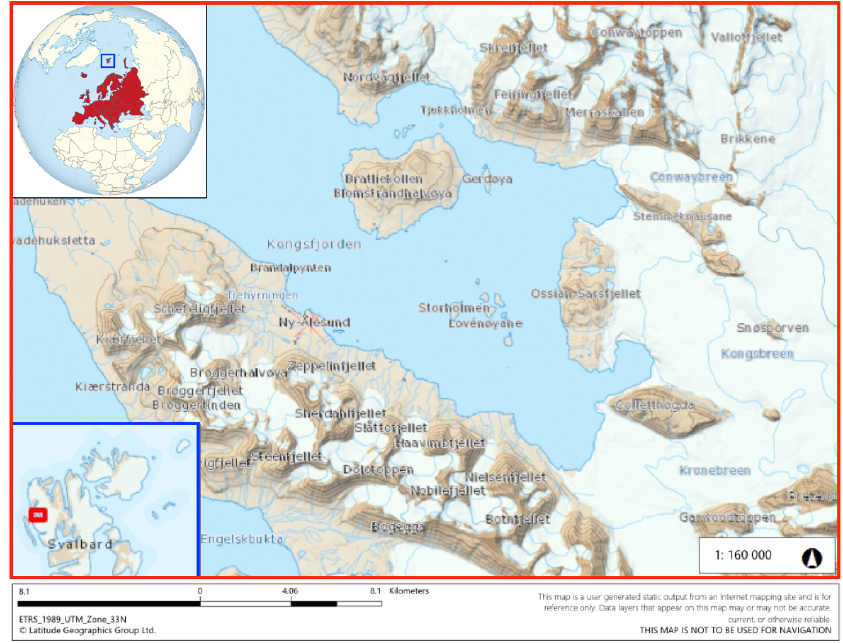
Figure 3. Map of the vicinity of Ny-Ålesund, Kongsfjord and its location in Europe. Sources: https://geokart.npolar.no/Html5Viewer/index.html?viewer=Svalbardkartet (accessed on 1 August 2022), courtesy of Norsk Polarinstitutt and https://de.wikipedia.org/wiki/Datei:Europe_on_the_ globe_(red).svg (accessed on 1 August